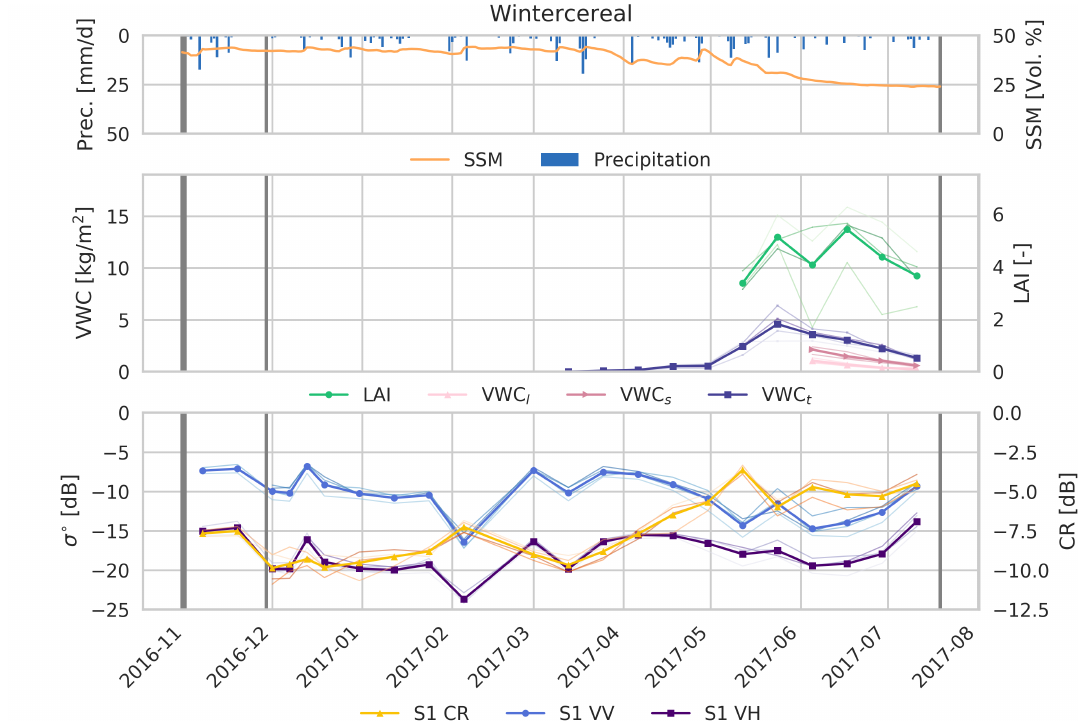
Figure 7. Time series of Sentinel-1 and in situ variables as in Figure 2 for winter cereal